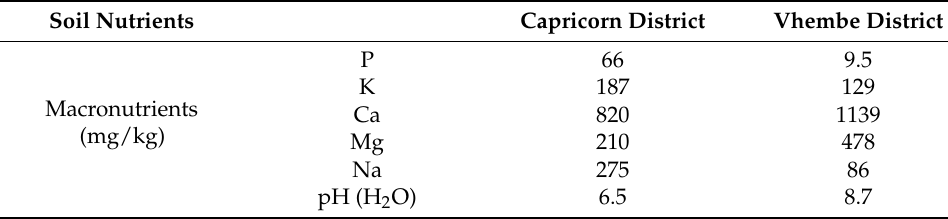
Table 3. Description of soil nutrients of the two districts (Capricorn and